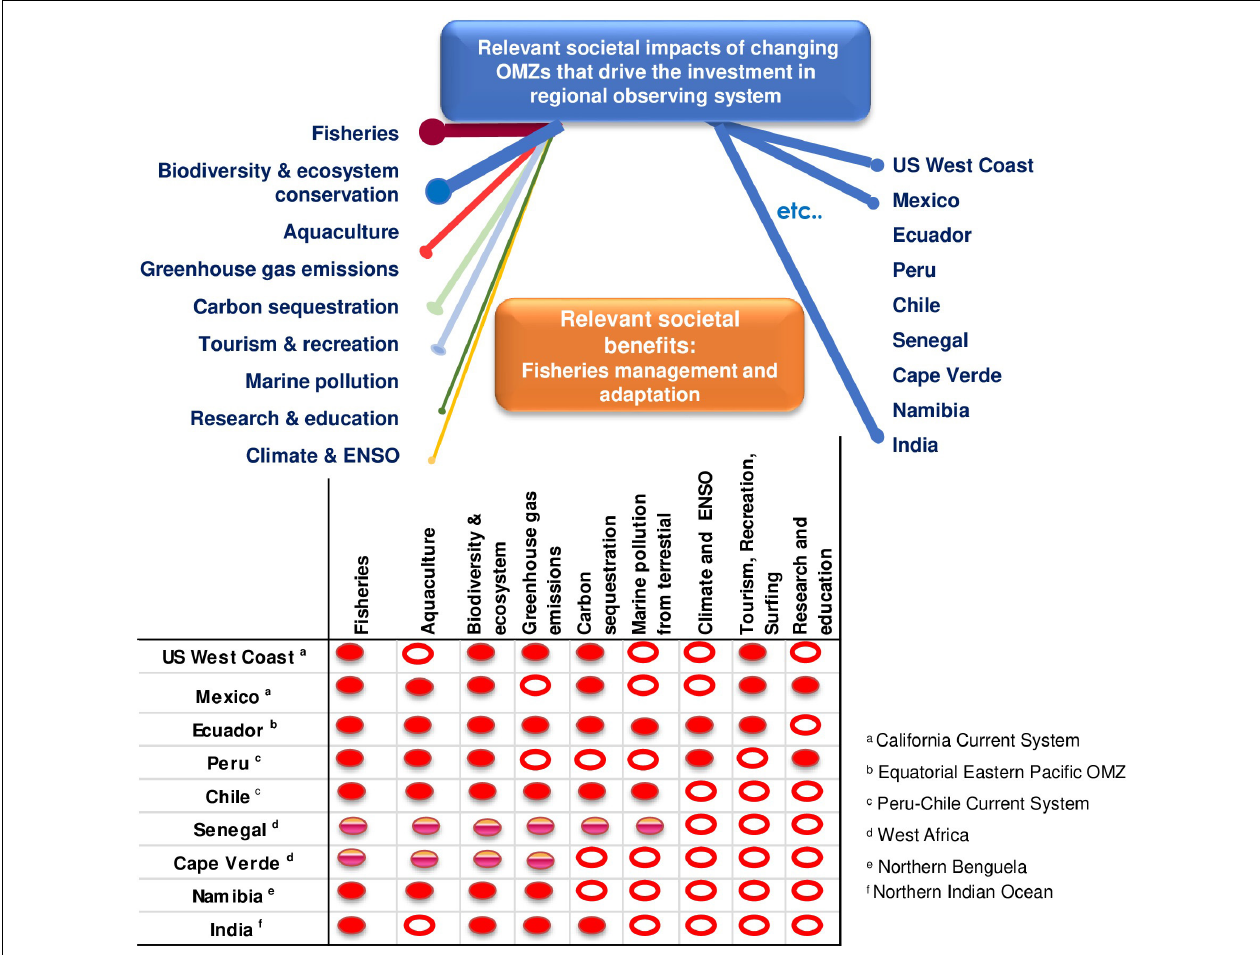
FIGURE 5 | Societal impacts and benefits are driving investments in a given oxygen minimum zone (OMZ) region of the world ocean. Shading indicates that these regions rely mostly on partnerships with foreign countries to carry out their monitoring activities. The two-toned pink oval indicates that the region relies mostly on partnerships with foreign countries, the filled red oval that the region is managing the monitoring at its own national level, and the outlined red oval that the region does not ensure the given monitoring activity. Please note it will not be repeated on all subsequent